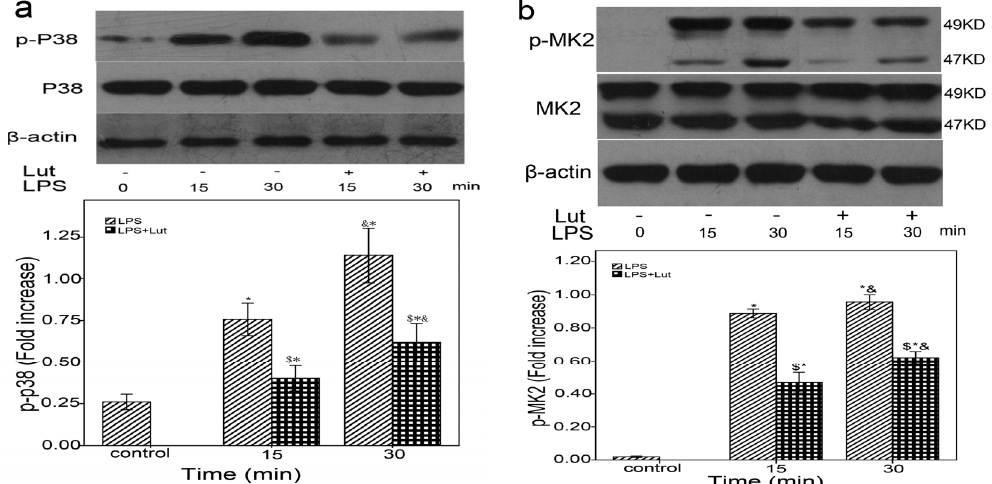
DMSO for 90 min, after incubated with or without LPS(1 μ g/mL) for the indicated times. The cell lysates were analyzed by the western blot method with antibodies p38, p-p38, MK2 and p-MK2. * p < 0.01 vs. control, & p < 0.01 vs. 15 min, $ p < 0.01 as (LPS + Lut group) vs. (LPS